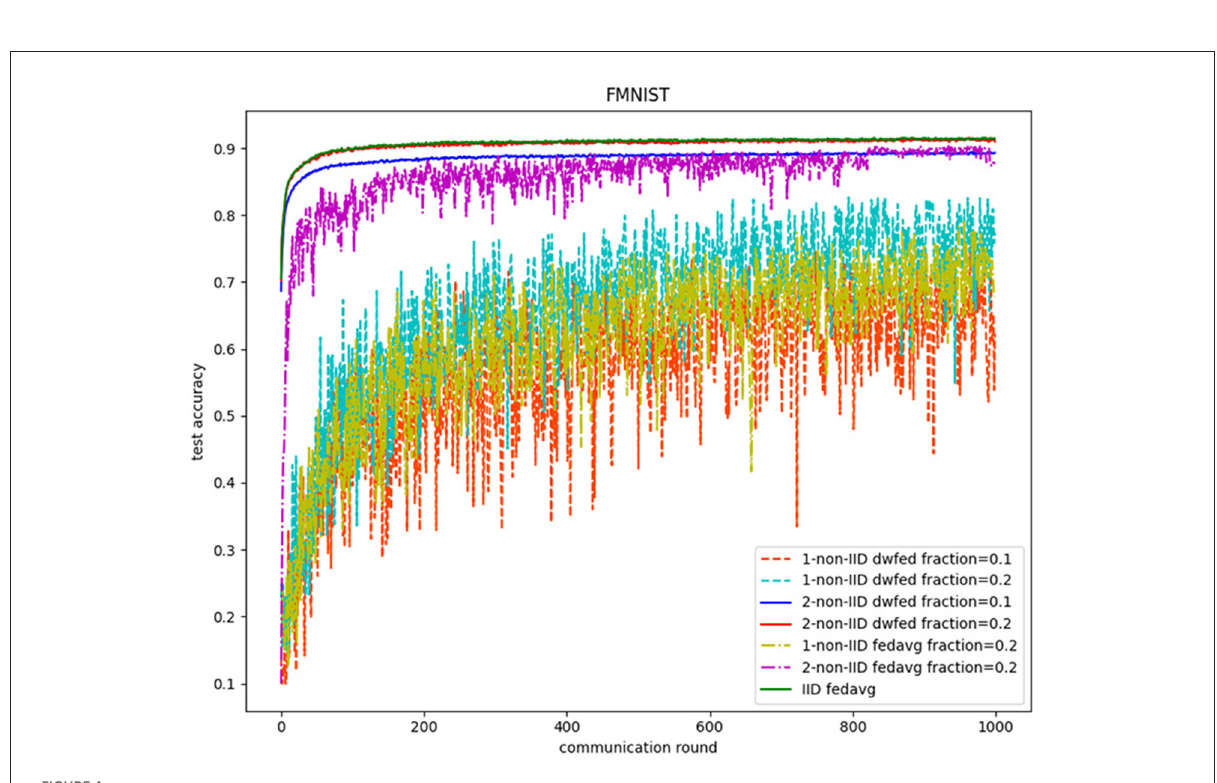
FIGURE4 Test accuracy on fashion